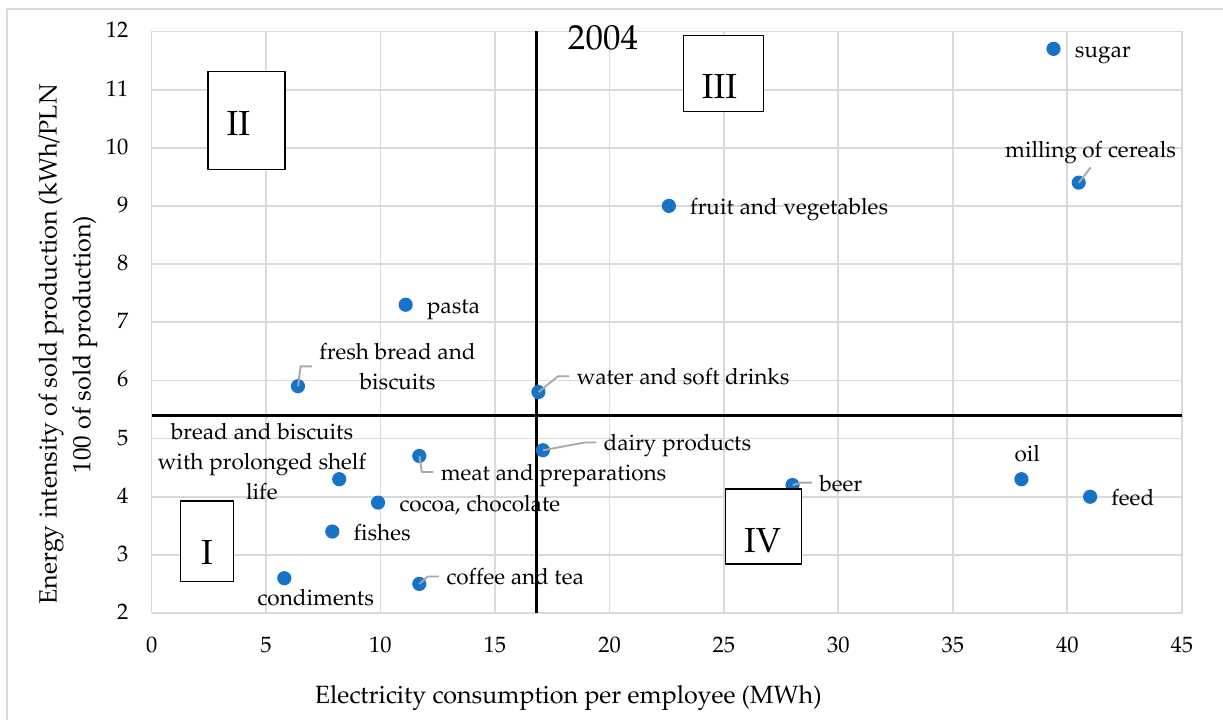
Figure 3. Distribution of selected food-industry production activities according to electricity con- sumption per PLN 100 of sold production and per employee in 2004. Source: own elaboration.